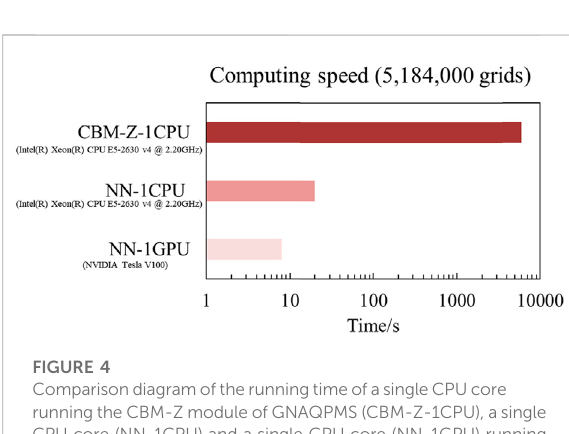
FIGURE 4 ComparisondiagramoftherunningtimeofasingleCPUcore running the CBM-Z module of GNAQPMS (CBM-Z-1CPU), asingle CPU core (NN-1CPU) and a single GPU core (NN-1GPU) running theneural network emulator to simulate gas phase chemistry on 518.4 million individual grid cells (global simulation of 20 vertical layers at 0.5 ° × 0.5 ° horizontal